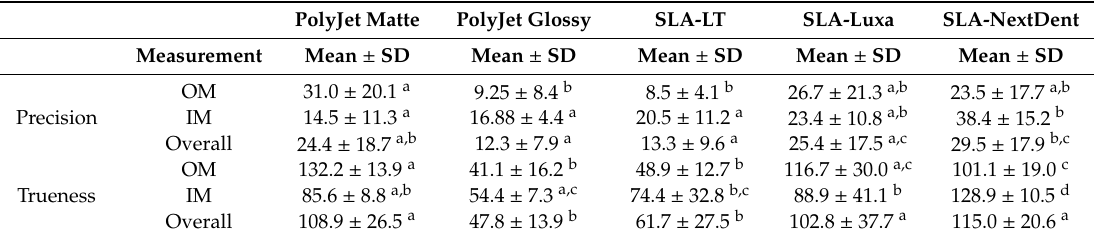
Table 2. Pre- sterilization RMS values (mean ± SD) ( µ m) of precision and trueness for outer, inner, and overall measurements of test bodies fabricated using di ff erent biocompatible resin materials.